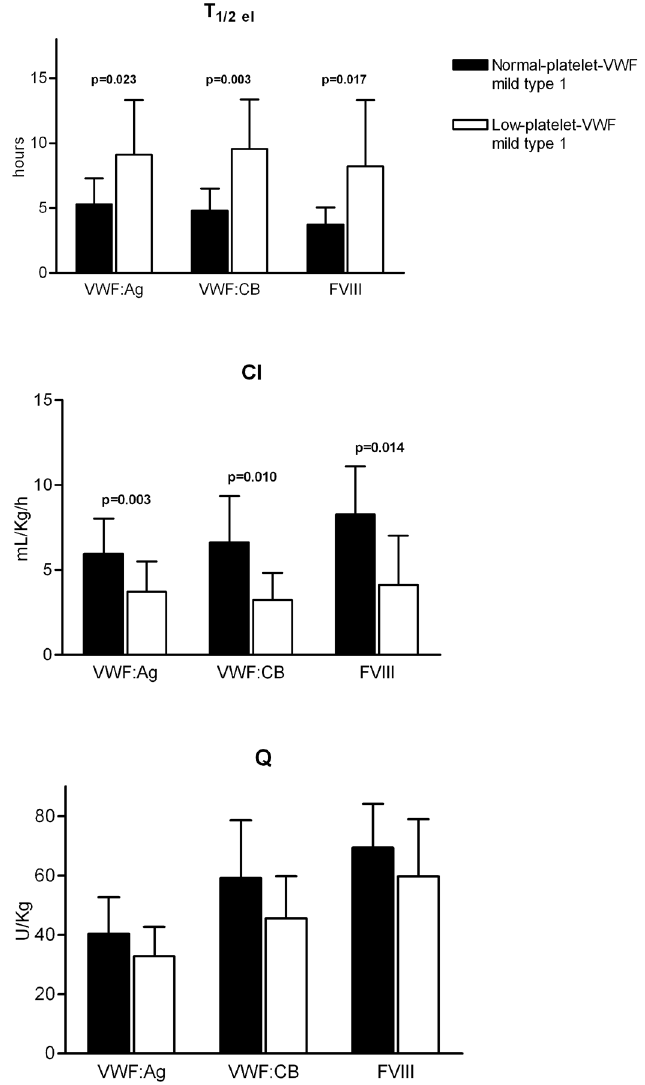
Fig 2. Mean post-DDAVP pharmacokinetic parameters of VWF:Ag, VWF:CB and FVIII in patients with normal-platelet-VWF and low-platelet-VWF mild type 1 VWD. The VWF T 1/2 elimination (T 1/2 el) was statistically shorter, and VWF clearance (Cl) was significantly faster in the former patients than in the latter.